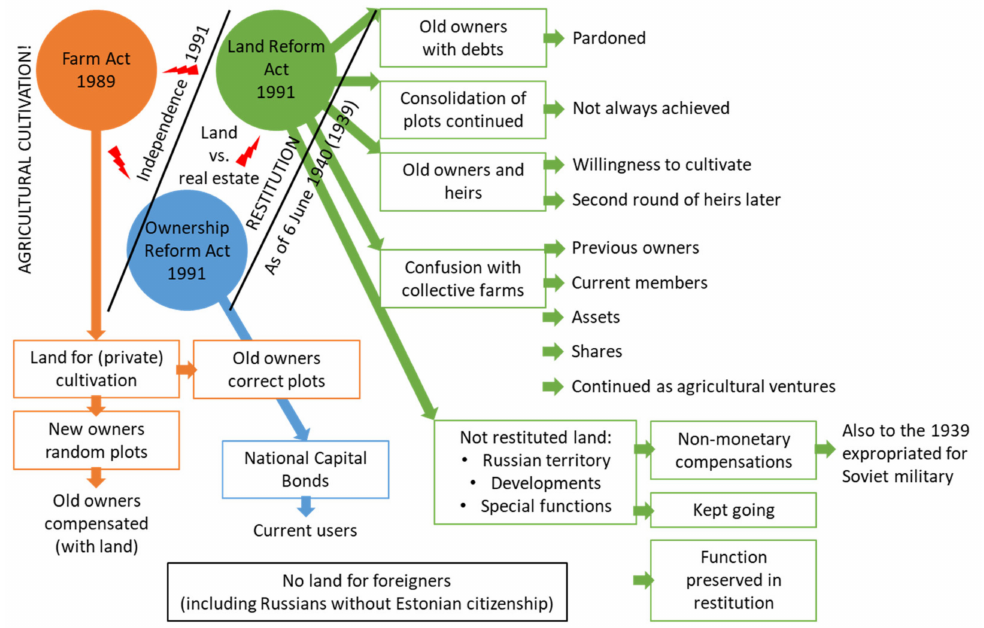
Figure 3. Scheme of the main intricacies of the land restitution